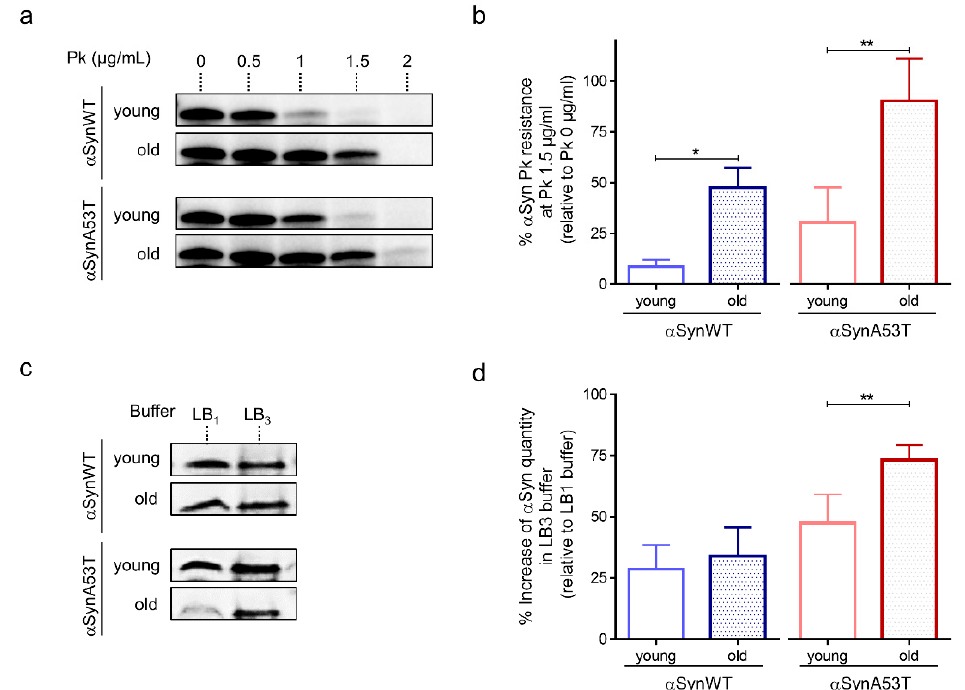
Figure 2. Age-dependent biochemical profile of α Syn protein in α Syn-expressing flies. ( a ) Proteinase-K (PK) resistance assay of α Syn performed on protein extracts from heads of α SynWT and α SynA53T expressing flies analyzed by Western blot with the anti- α Syn MJFR1 antibody. The lanes show increasing concentration of PK (from 0 to 2 µ g/mL) for young (1-day-old) or old (40-day-old) flies. ( b ) The graph shows the percentage of protein remaining after digestion with 1.5 µ g/mL PK concentration (relative to the undigested sample) in young (before 20-day-old) or old (at least 40-day-old) for α SynWT and α SynA53T expressing flies. Western blot signals were measured by densitometry using the software Image lab version 5.2.1 build 11. Quantifications showed a significant increase in α Syn PK resistance between young flies and old flies for α SynWT (n = 4) and α SynA53T (n = 7). Data are shown as means ± standard deviations. p -values of the group differences were calculated using t -test (* p = 0.0335 and ** p = 0.0086, respectively). ( c ) Soluble α Syn protein detection after extraction with denaturating buffers of increasing strength (LB1 < LB3). Western blot assessment (with the MJFR1 antibody) of α Syn protein in the soluble fraction of LB 1 0.5% NP40 and LB 3 urea/thiourea lysis buffers on young (1-day-old) or old (40-day-old) flies expressing α SynWT or α SynA53T. ( d ) The graph shows the percentage of protein quantity in LB3 relative to LB1 for young and old flies (n = 7 for α SynWT and n = 8 for α SynA53T). Data are shown as mean with standard deviation. p -values of the group differences were calculated using t -test (** p = 0.005). Flies were raised on standard corn meal food supplemented with yeast.